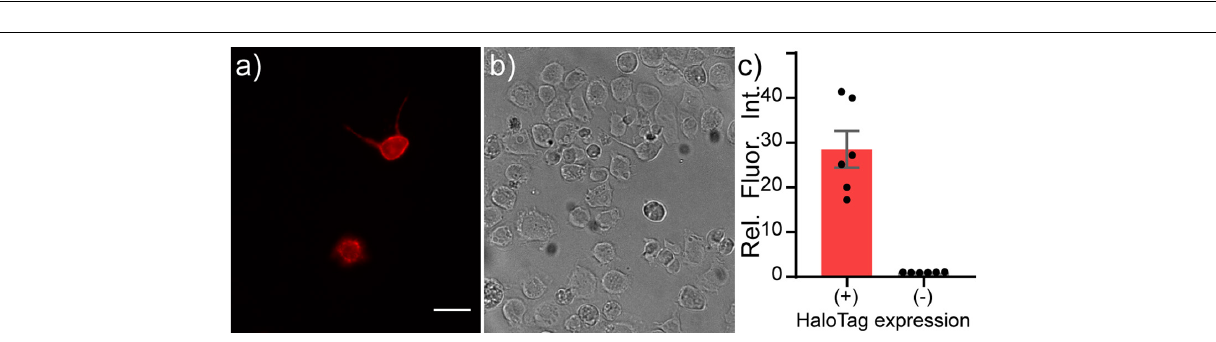
(Figure 6a ). Non-transgenic fly controls show low fluorescence levels in the brain and antennal lobe (GH146-GAL alone, Figure 6b ). TMR-Halo in combination with HaloTag-CD4 can